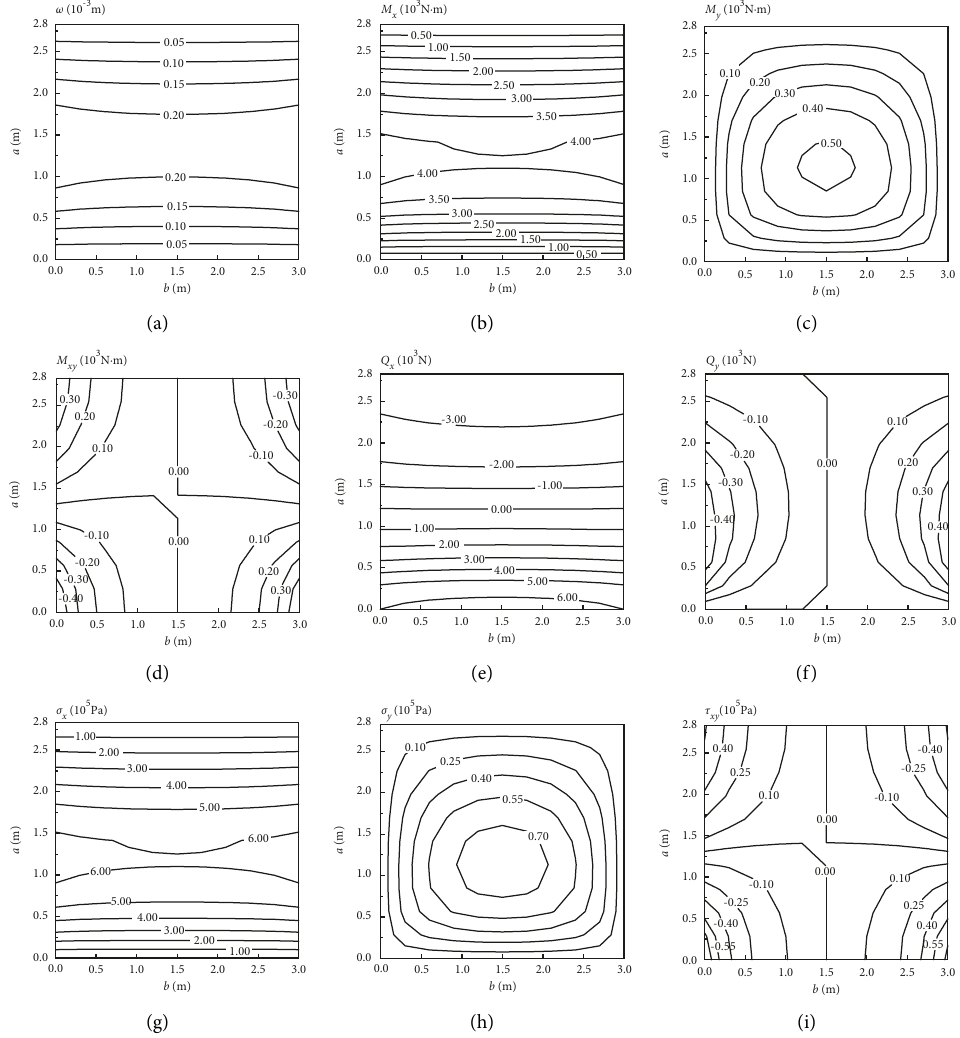
Figure 6: Distribution of deflection, internal force, and stress of slope